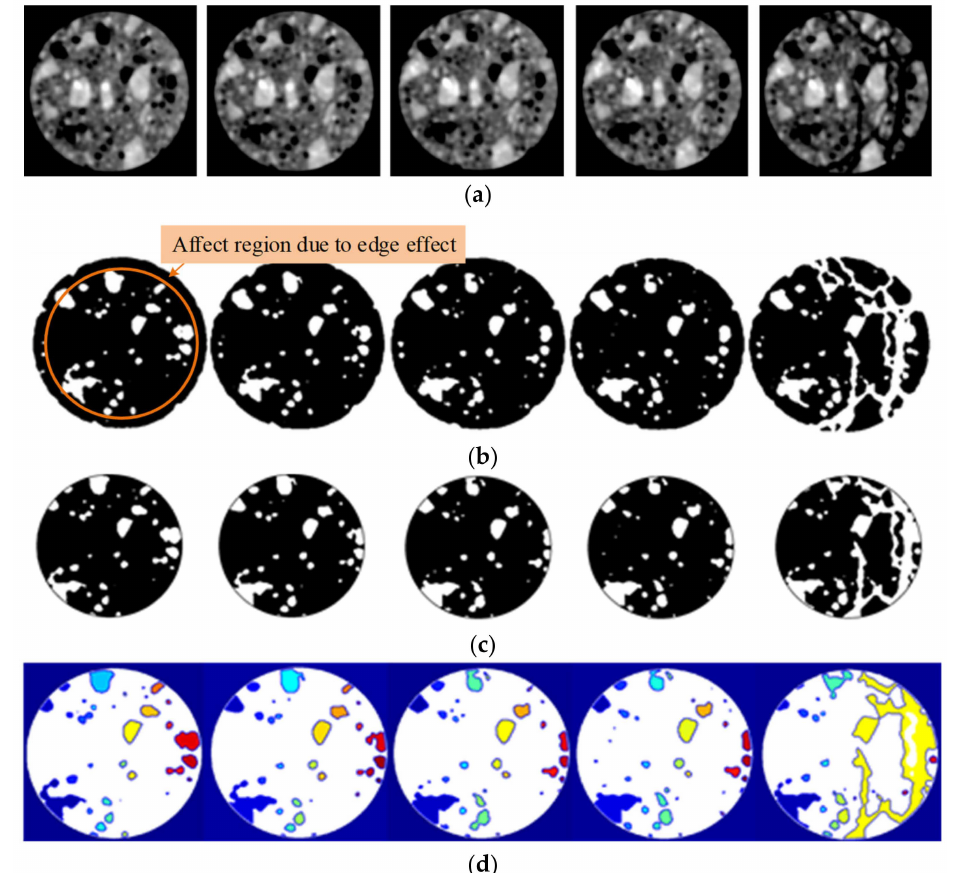
Figure 5. Crack and hole region extraction, cropping, colored for highlighingt, ( a ) Original CT images in the same slice at different scanning stages, ( b ) Binary images of holes and cracks, ( c ) Binary images of holes and cracks being cropped, ( d ) Holes’ and cracks’